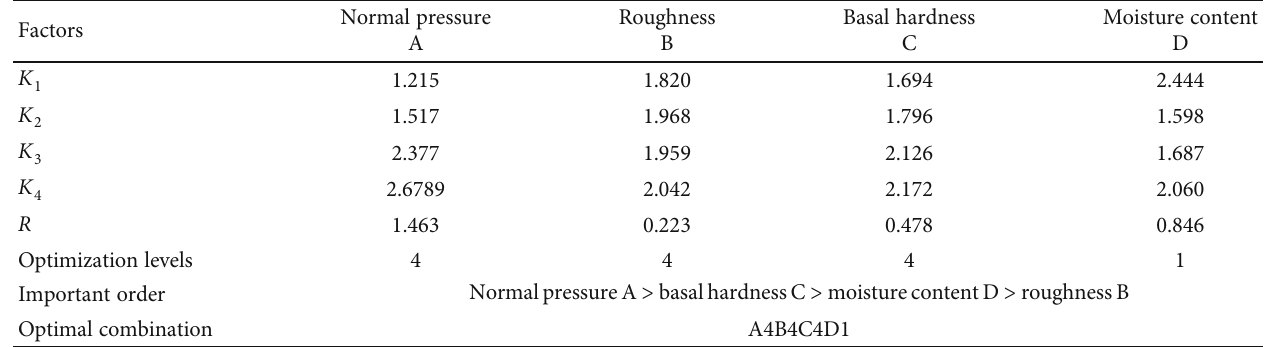
Table 6: Intuitive analysis results of shear strength.